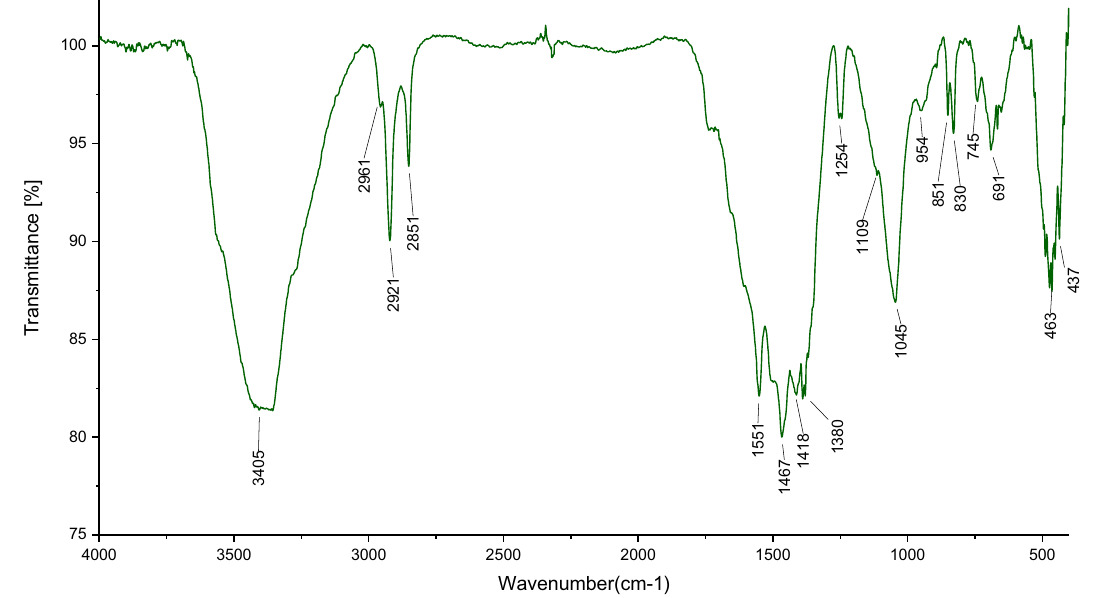
Figure 10. FT-IR Spectrum of spent nanoporous Zn-MOF catalyst.